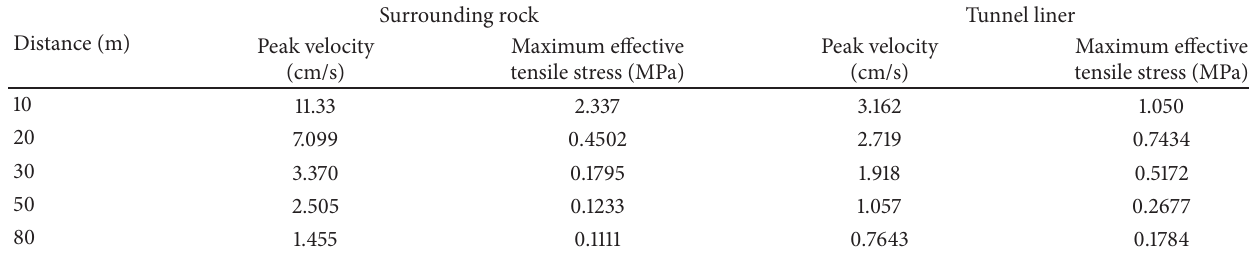
Table 6: Safety criterion